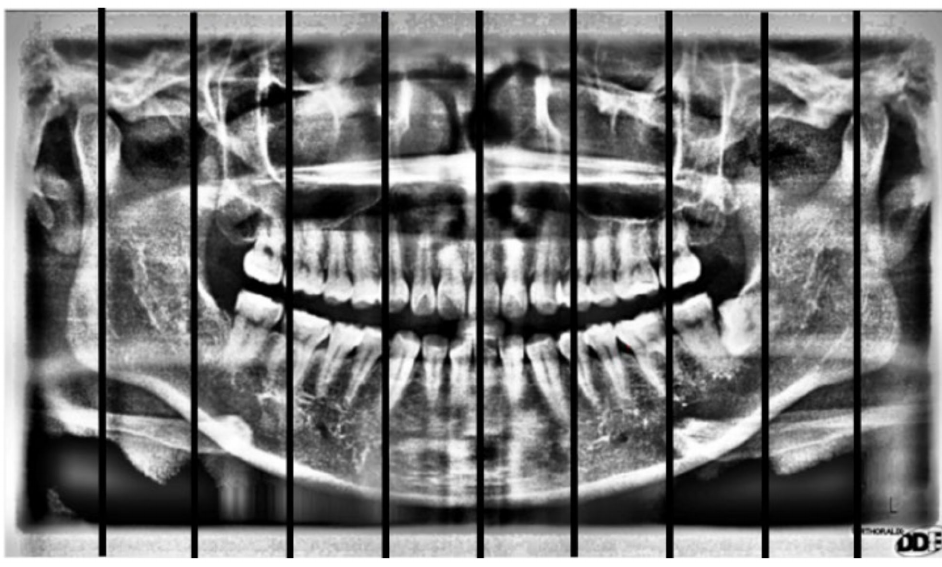
Figure 10. An image cut into 10 equal